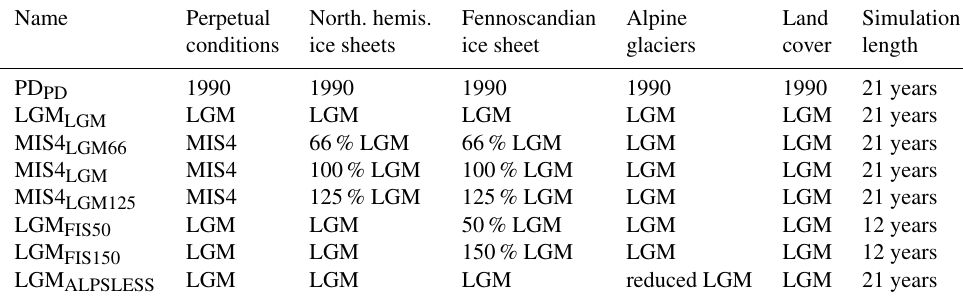
Table 2. Set of experiments carried out in this study. The first column indicates the name of the WRF simulation, the second column the perpetual conditions, the third column the northern hemispheric ice sheets (this includes the modifications in the driving global model), the fourth column the FIS, the fifth column the Alpine glaciers, the sixth column the land cover, and the seventh column the length of the